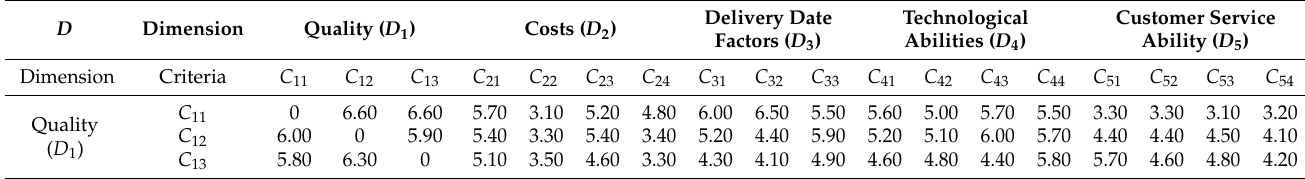
Table 4. Direct influence